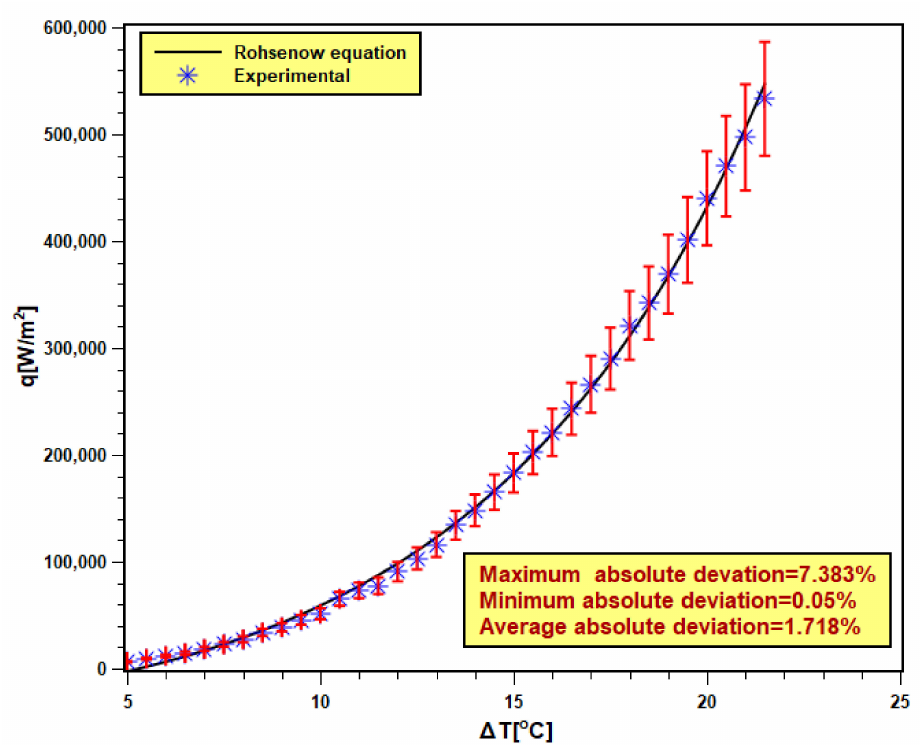
Figure 9. Validation of experimental data with Rohsenow equation